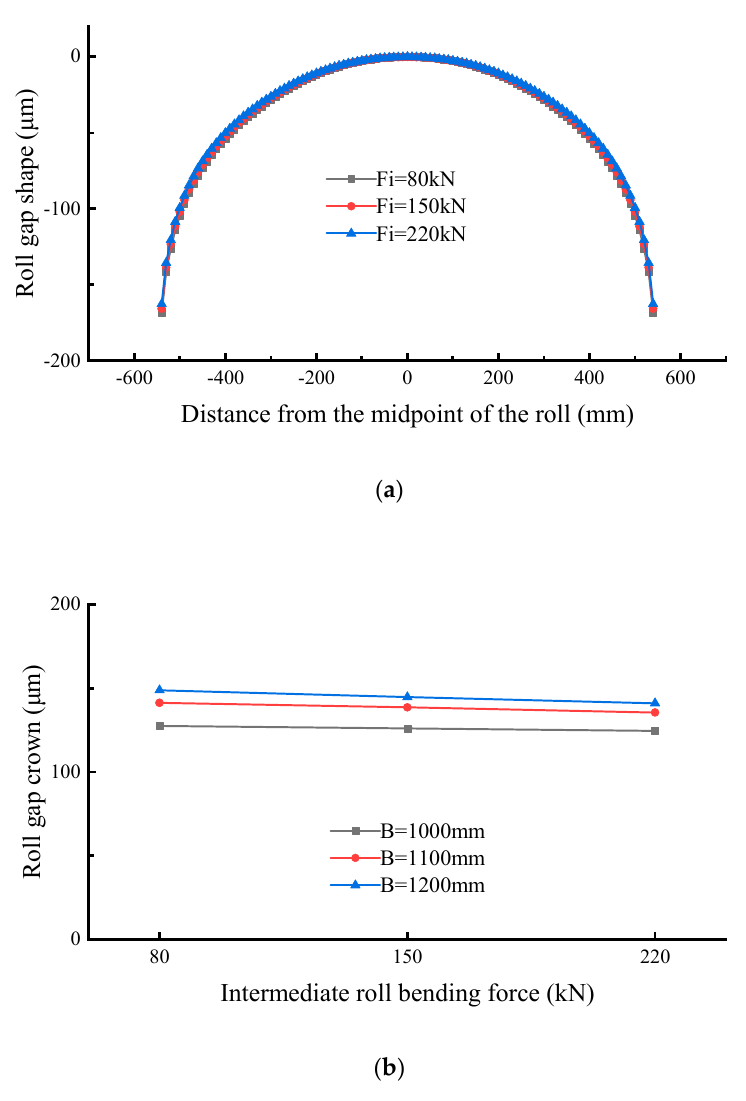
Figure 7. Effect of intermediate roll bending force on roll gap shape. ( a ) Roll gap shape under different intermediate roll bending forces, ( b ) effect of intermediate roll bending force on roll gap crown.